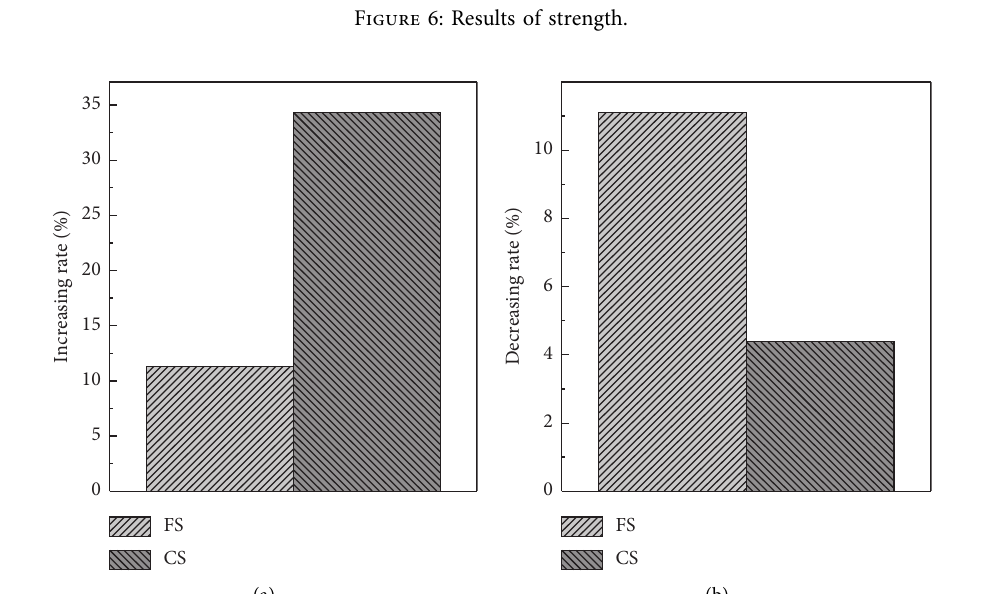
Figure 6: Results of strength.